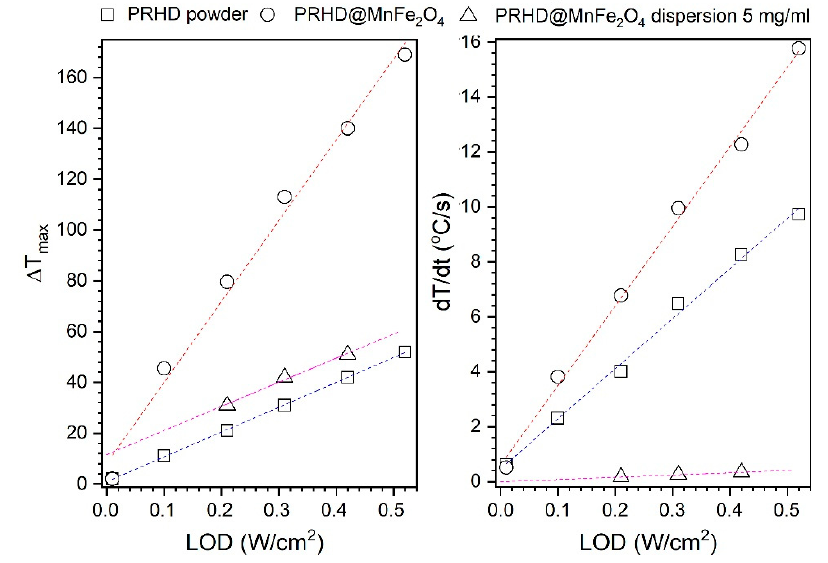
Figure 7. Dependence of the LOD on ∆ T max and dT / dt for the dry PRHD, PRHD@MnFe 2 O 4 hybrids, and colloidal suspension of PRHD@MnFe 2 O 4 (5 mg / mL) under stimulation of 808 nm NIR.